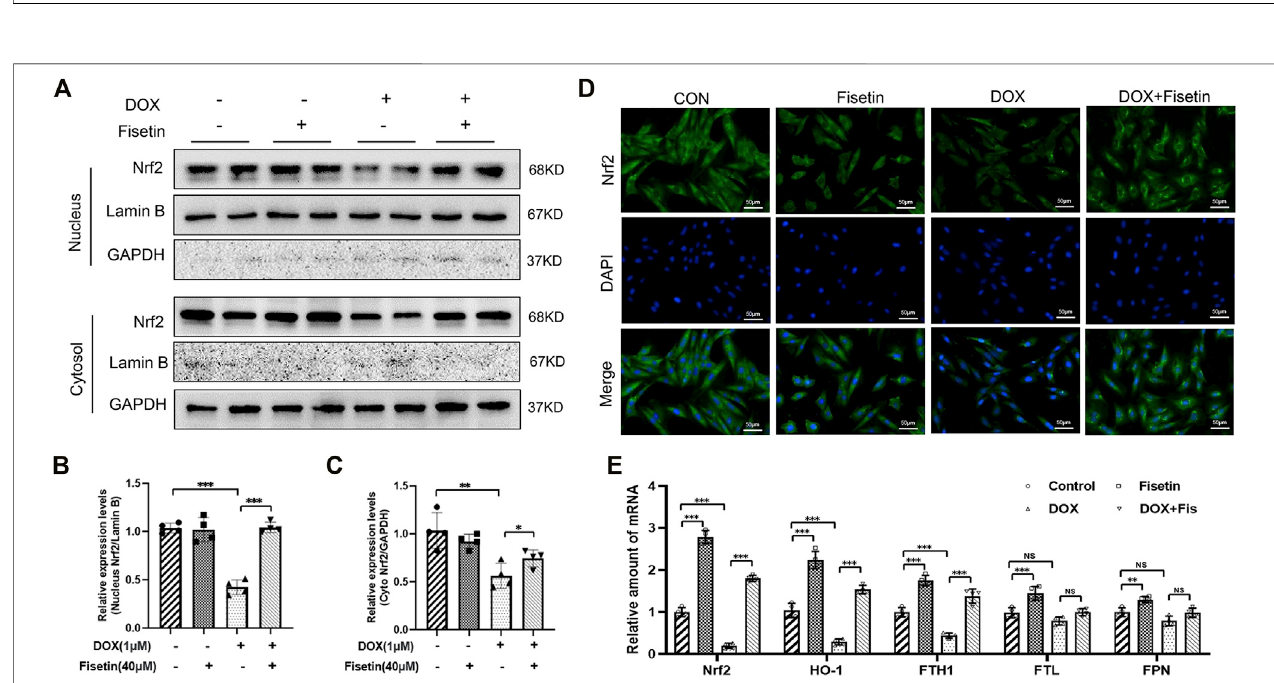
FIGURE5| Fisetin activates Nrf2 and Nrf2 pathways in H9C2 cells. (A) . Western blot of nuclear and cytosol Nrf2 levels in vitro . (B). Nuclear Nrf2/labmin B ratio was quanti fi ed by ImageJ analysis. (C) . Quanti fi cation of cytosol Nrf2/GAPDH ratio. (D) . Detection of the Nrf2 expression and translocation using immuno fl uorescence (IF) staining in different groups. (Representative images, 200X, Scale bar = 50 μ m). (E) . mRNA levels of Nrf2, HO-1, FTH1, FTL, and FPN were detected by real-time PCR in different group cells. The values are presented as mean ± SD. ** p < 0.01; *** p < 0.001, NS, no signi fi cance; Nrf2, nuclear factor erythroid 2-related factor 2; Keap1, Kelch-like ECH-associated Protein 1; HO-1, heme oxygenase-1; FTH1, ferritin heavy chain 1; FTL, ferritin light chain; FPN, ferroportin; TfR1, transferrin receptor 1.